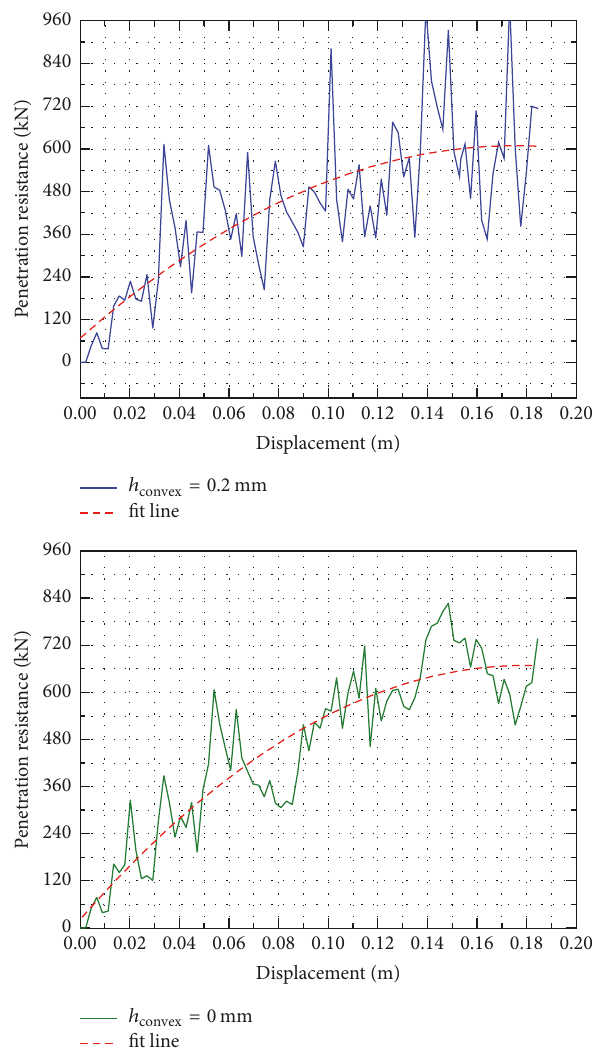
Figure 5: Penetration resistance of different surface nose as a function of the penetration depth. The constant penetration velocity is 450